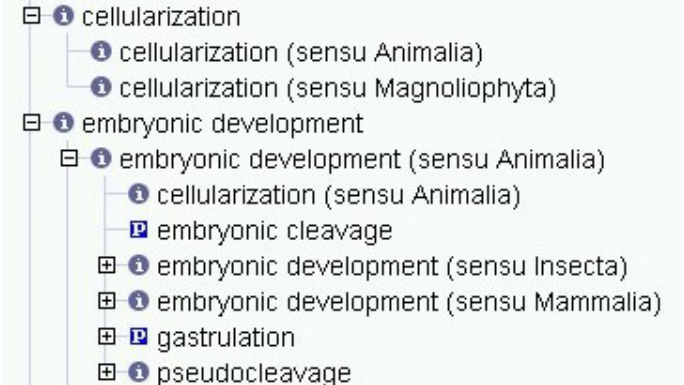
Figure 5 GO hierarchy of concepts related to